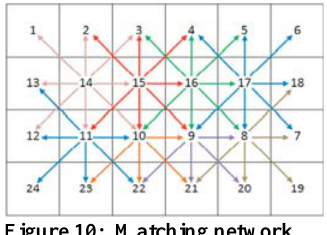
Figure 10: Matching network